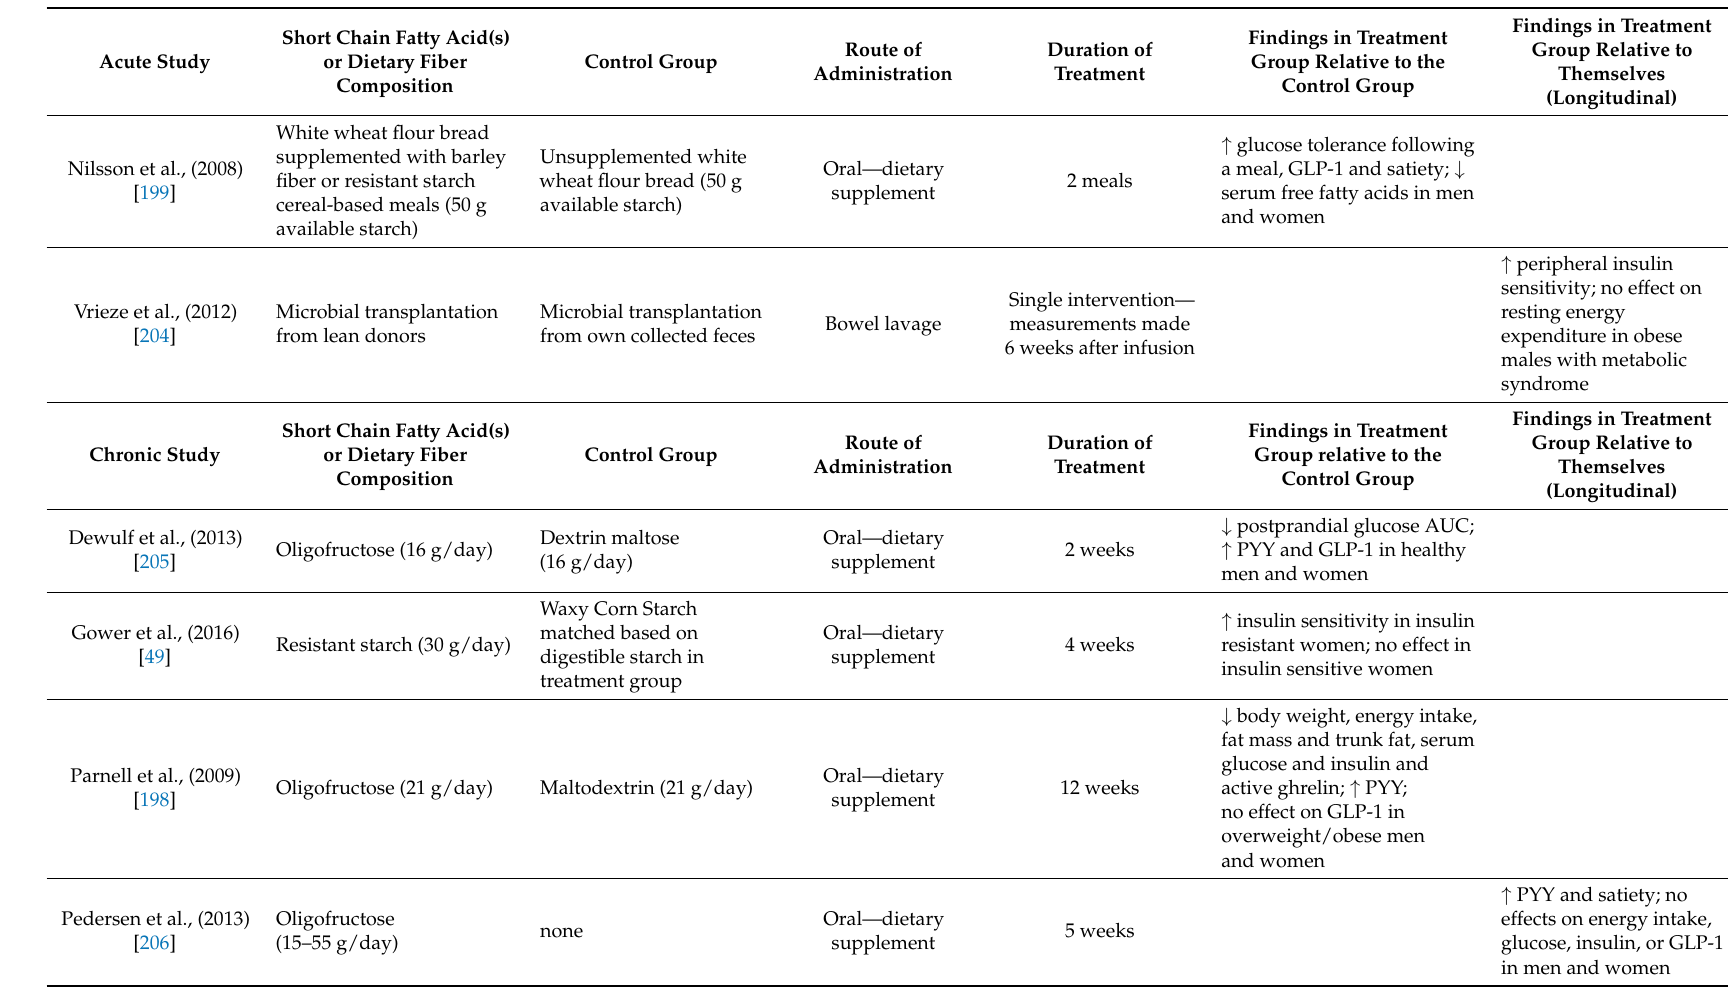
Table 1. Effects of butyrate, dietary fiber, or microbial transplantation treatment on body weight, body composition, inflammation, satiety hormones and/or insulin sensitivity in human participants. Upward arrows ( ↑ ) indicate an increase and downward arrows ( ↓ ) indicate a decrease in respective measured